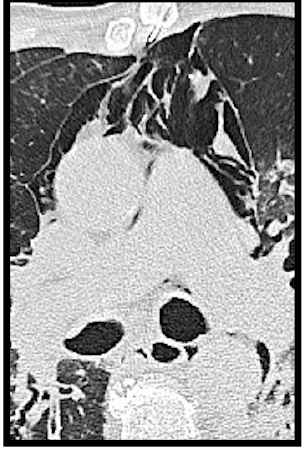
Figure 7. Spontaneous right pneumothorax extended from apex to lung base. Axial ( A ); coronal ( B ); the right lung appears hypo-expanded.